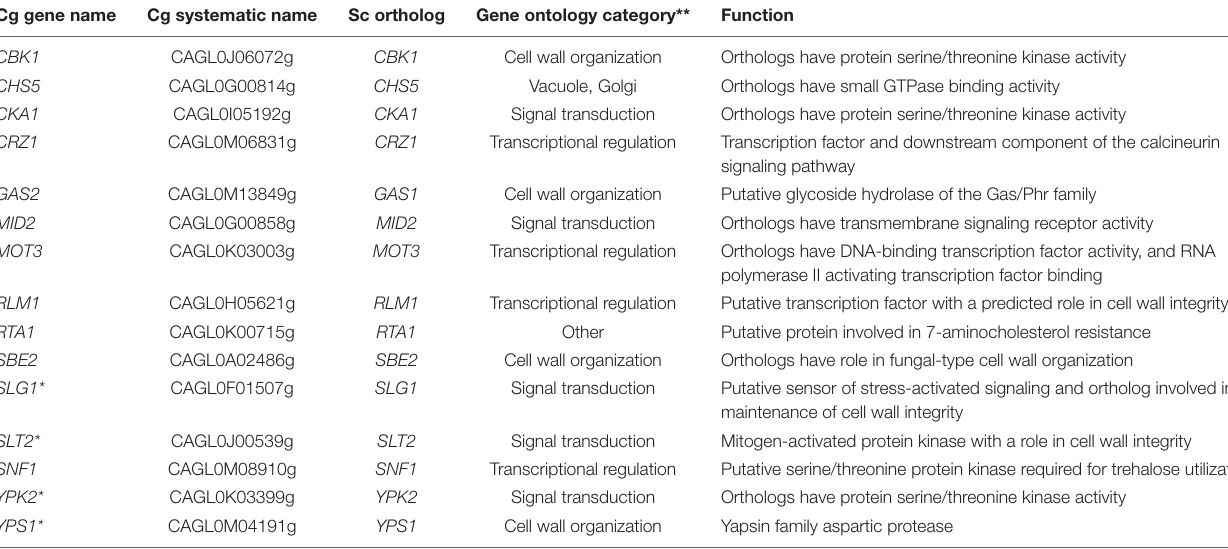
TABLE 1 | Fifteen Candida glabrata genes whose deletion mutants were analyzed for echinocandin tolerance in vitro